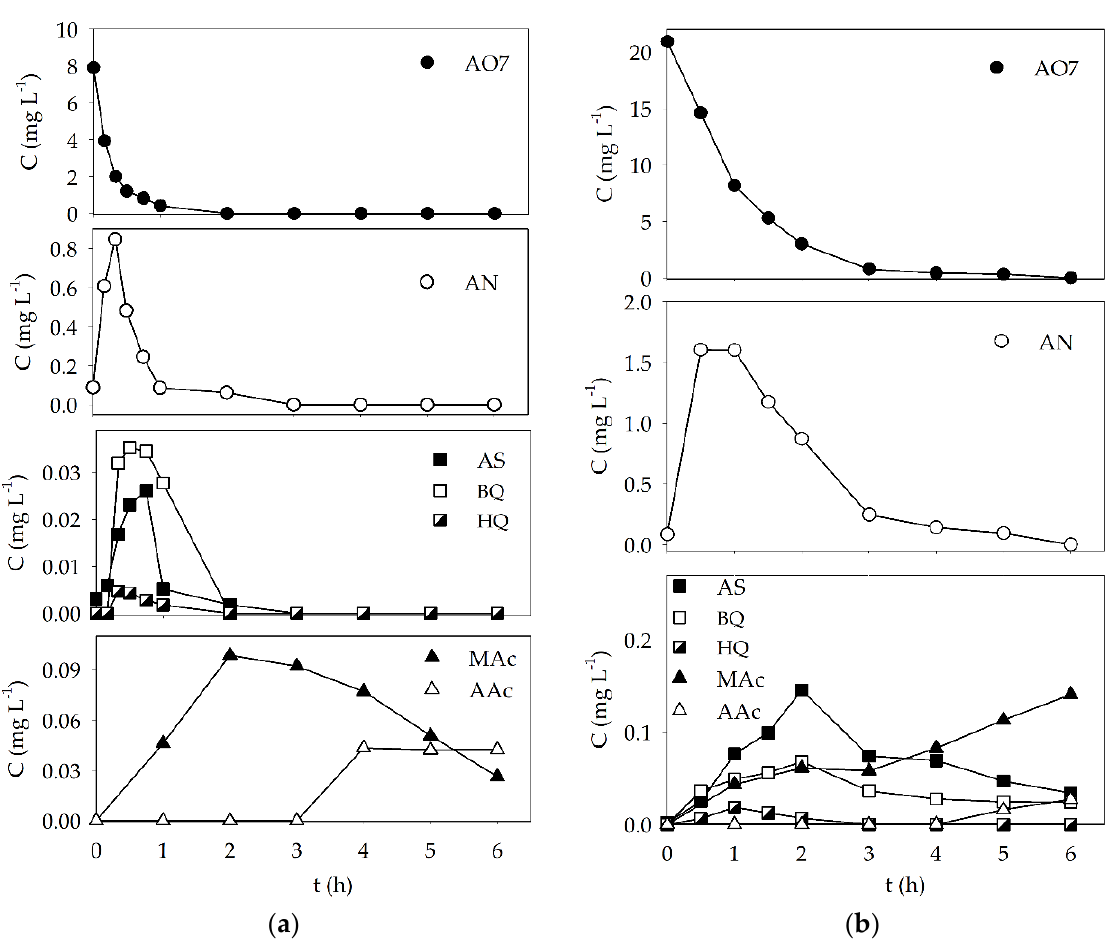
Figure 5. Concentration variation for the AO7 dye and some degradation products during the photocatalytic degradation of ( a ) 10 mg L −1 and ( b ) 25 mg L −1 of AO7 under visible light with Sr 0.95 Bi 0.05 TiO 3 perovskite (0.2 g L −1 ).